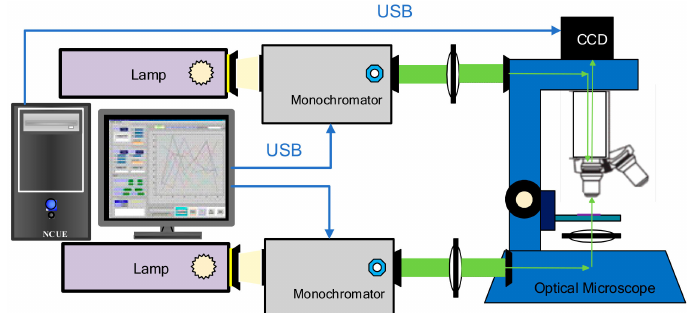
Figure 1. The schematic of the hyperspectral microscopic system. The excitation light sources are halogen lamps. The excitation light passes through a monochromator before entering the objective for both reflection mode and transmission mode. A CCD camera is used to capture images. A computer is used to synchronously control the monochromators and the camera for hyperspectral imaging.